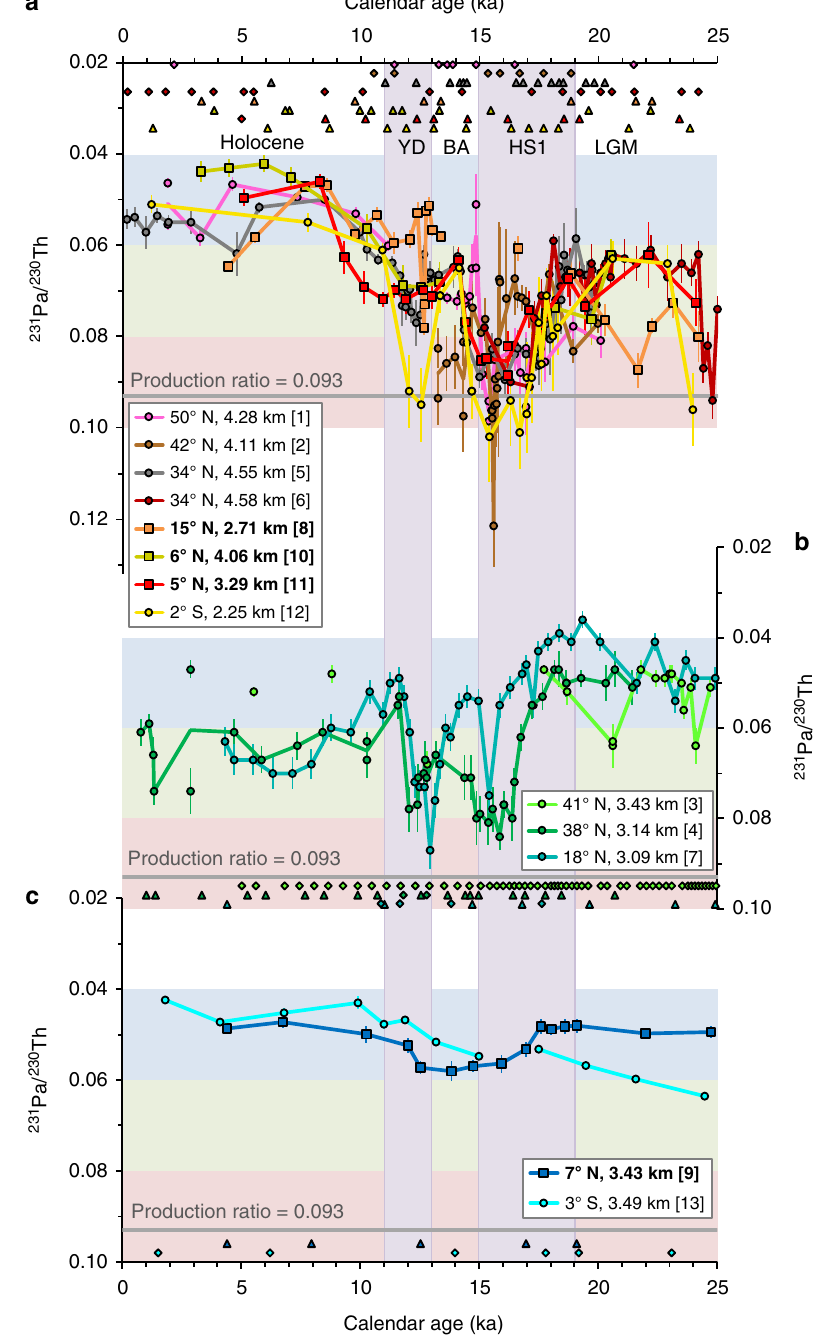
Fig. 2 Atlantic sedimentary 231 Pa/ 230 Th records that re fl ect past changes in circulation rate. a West Atlantic and deep high-latitude (>50° N) North Atlantic records, b deep subtropical North-East Atlantic and Mid-Atlantic Ridge (MAR) records, and c deep low-latitude East Atlantic records. Error bars represent 2 s.e.m. Red, green and blue shading categorise the 231 Pa/ 230 Th ratios into high, middle and low values, respectively. Triangle and diamond symbols respectively signify 14 C and non- 14 C chronological tie-points. Bracketed numbers denote the identity of the sediment cores marked in Fig. 1, with references listed in Table 1. Bold characters in the fi gure legend and the square symbols indicate new 231 Pa/ 230 Th reconstructions from this study. Annotations of key climate events: LGM Last Glacial Maximum, HS1 Heinrich Stadial 1 (purple shading), BA Bølling-Allerød, YD Younger Dryas (purple